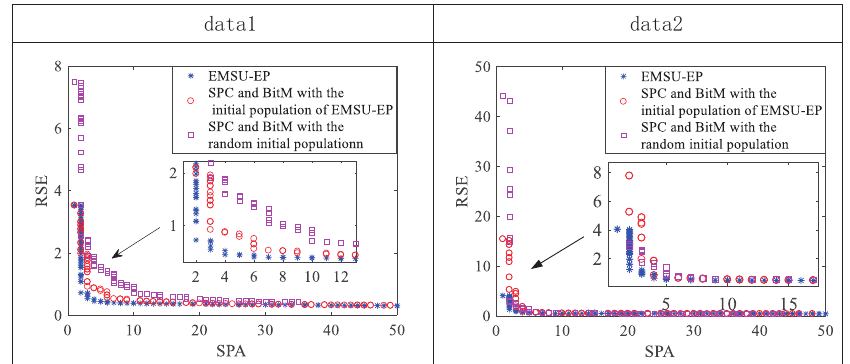
Figure 6. Illustration of the Pareto Front of the 50th generation on data 1 and data